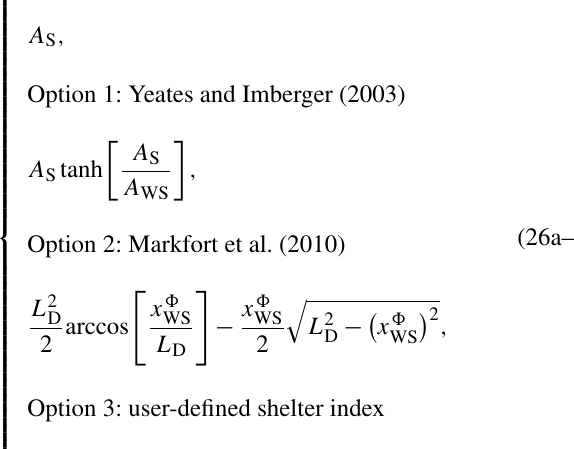
Figure 4. Example light data outputs from a GLM application to Woods Lake, Australia, showing (a) the ratio of benthic to surface light, /φ SW (%), overlain on the lake map based on the bathymetry, with the area where f BEN 100 φ PAR BEN 0 irradiance) depicted in grey, (b) a time series of the depth variation in light (Wm − 2 ), and (c) a time series of A BEN /A s (as %) for various f BEN . Note that the 2-D projection of the 1-D lake model in (a) can assist in managing the lake condition but assumes uniformity of K w crit